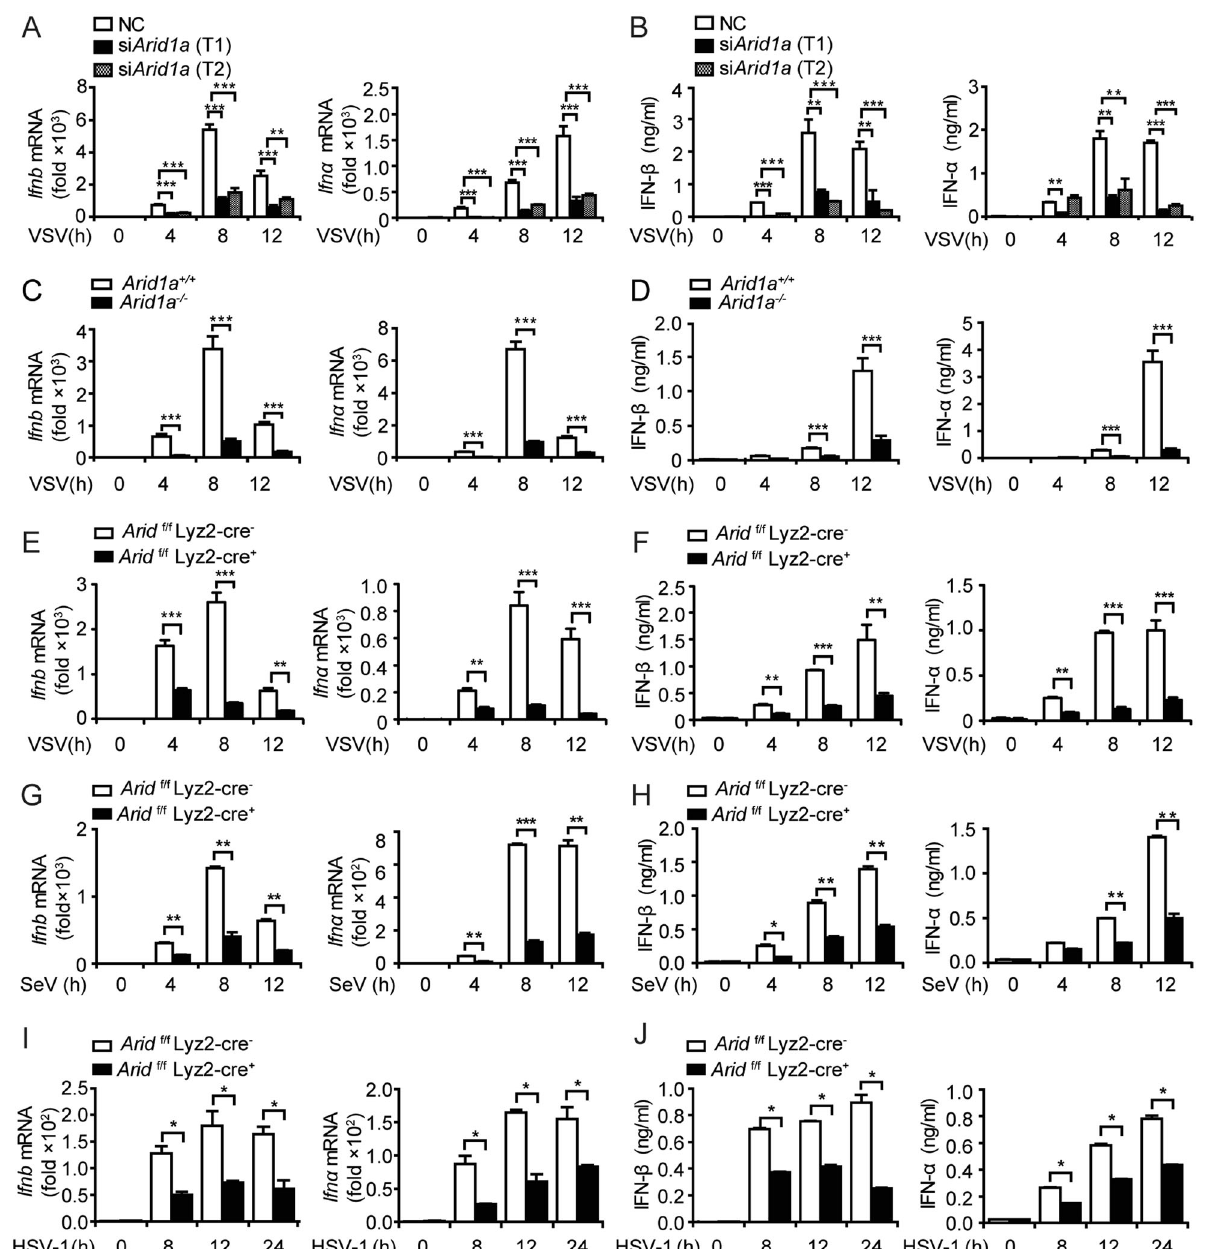
Fig. 1 Inhibition of Arid1a suppresses IFN-I production upon virus infection. A – D qPCR analysis of Ifn-I ( A , C ) and ELISA analysis of IFN-I ( B , D ) expression in PMs silenced ( A , B ) by two speci fi c Arid1a siRNAs or non-coding (NC) siRNA and Arid1a knock-out RAW264.7 ( C , D ) and control cells in response to VSV (MOI, 1) infection at the indicated times. E – J qPCR analysis of Ifn-I ( E , G , I ) and ELISA analysis of IFN-I ( F , H , J ) expression in Arid1a f/f Lyz-Cre - and Arid1a f/f Lyz-Cre + BMDMs in response to VSV (MOI, 1) ( E , F ), SeV (MOI, 1) ( G , H ) or HSV-1 (MOI, 10) ( I , J ) infection at the indicated times. Error bars represent s.d. Student ’ s t -test. * P < 0.05, ** P < 0.01, *** P < 0.001. All data are representative of three independent experiments with three biological replicates. ( A – J : mean ±